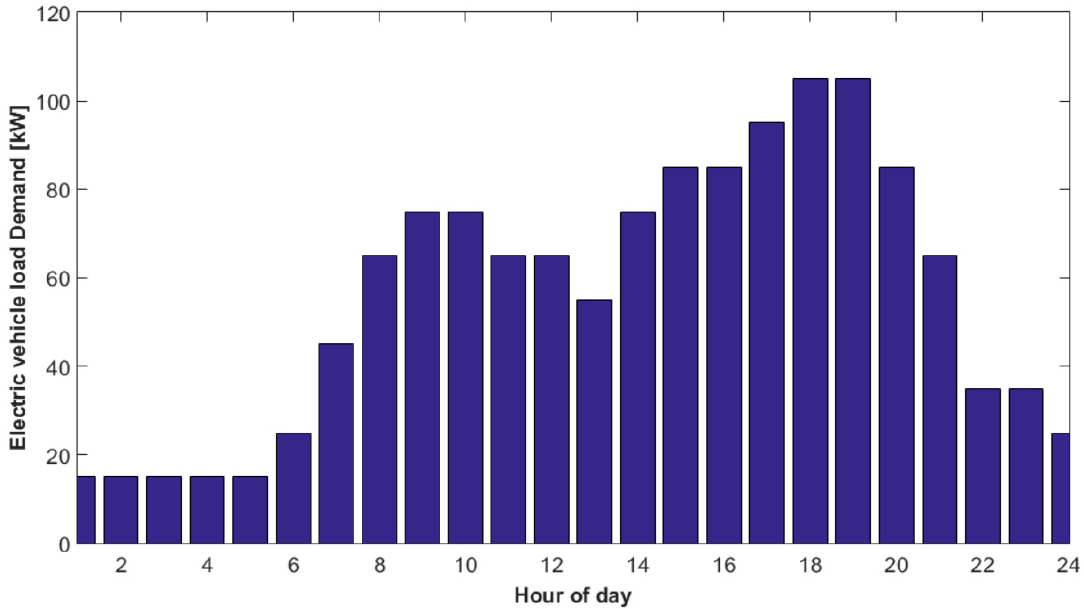
Figure 10. Electric vehicle load profile supplied by the DC-microgrid.